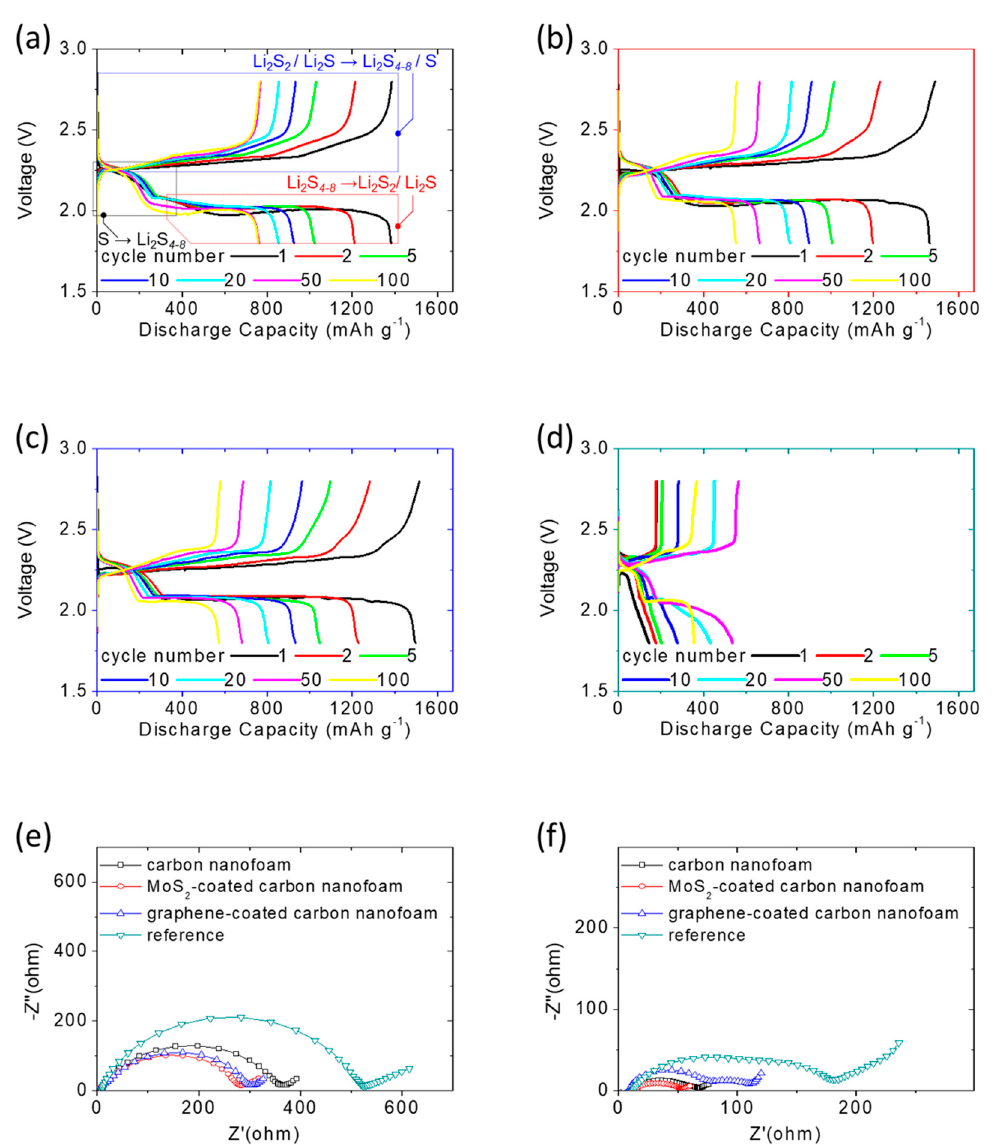
Figure 3. Electrochemical analysis: discharge/charge voltage profiles of the sulfur cathodes at the C/20 rate with ( a ) the carbon-nanofoam interlayer, ( b ) the MoS 2 -coated carbon-nanofoam interlayer, ( c ) the graphene-coated carbon-nanofoam interlayer, and ( d ) the reference cathode; and impedance analysis of the sulfur cathodes with carbon-nanofoam interlayers ( e ) before and ( f ) after 100 cycles.